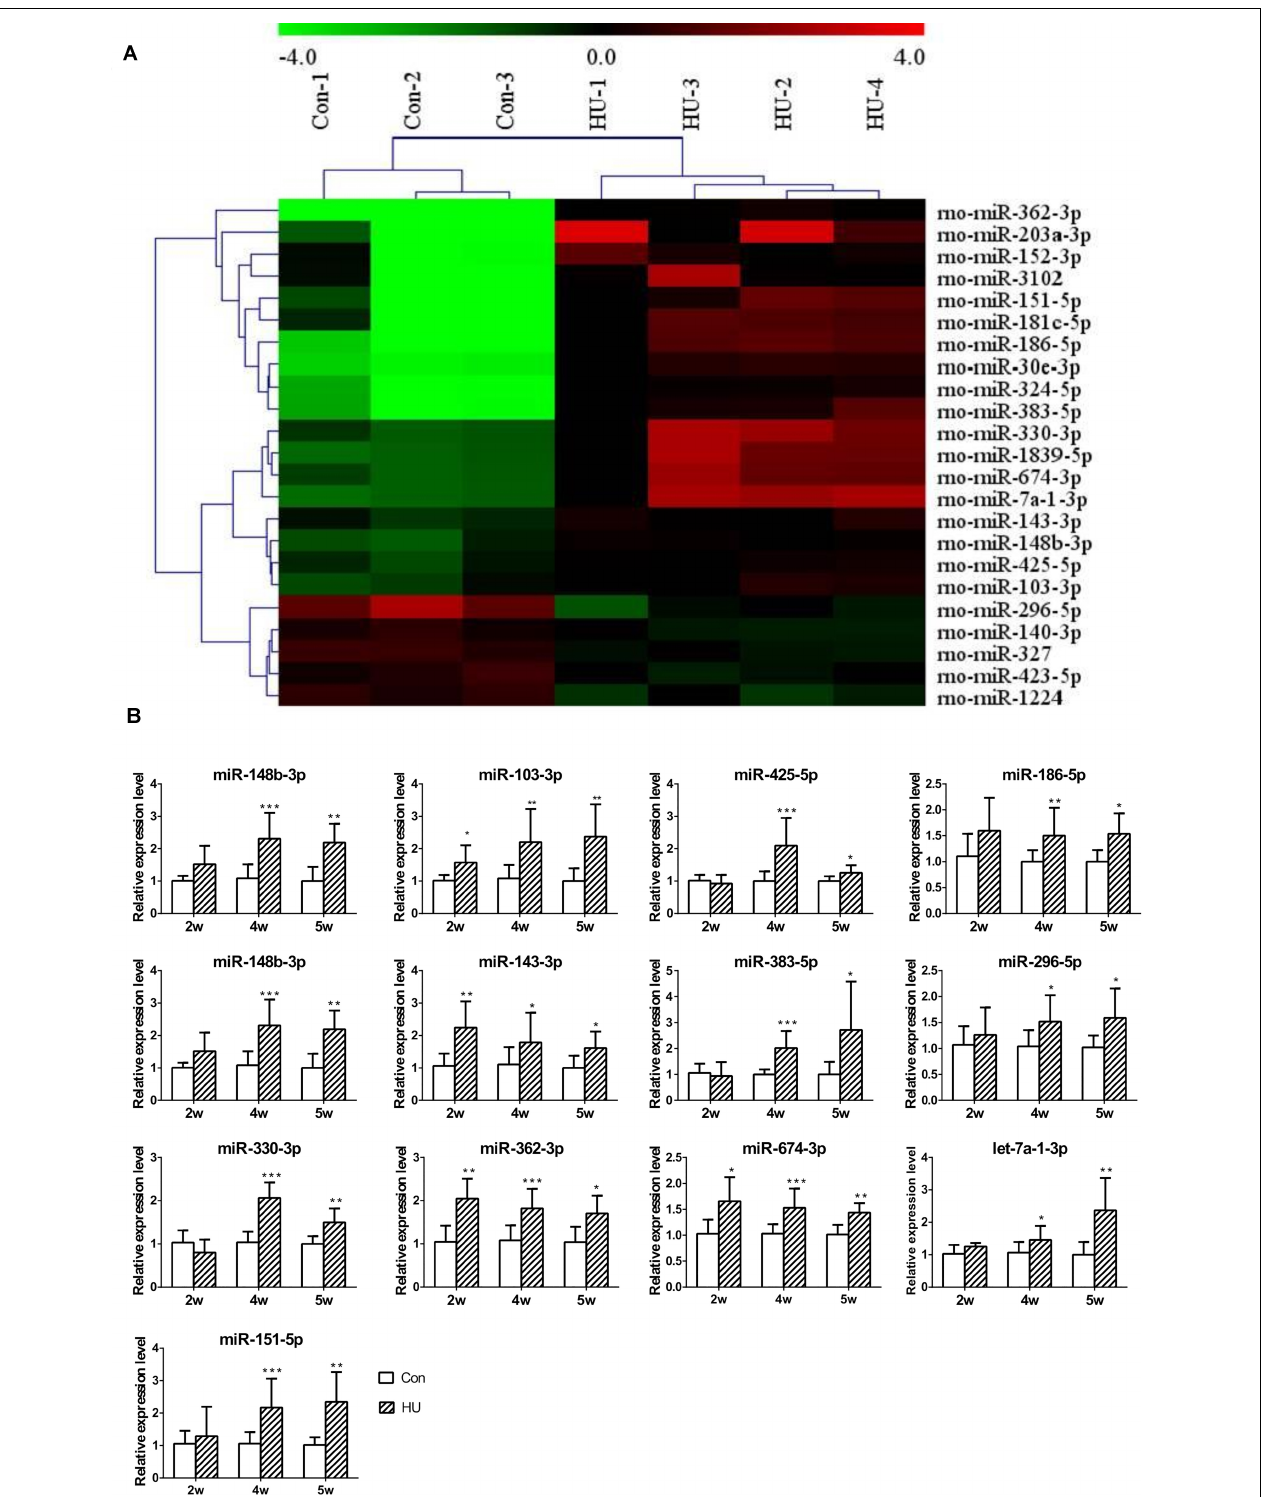
FIGURE 2 | Analysis of differential expression of serum miRNAs in HU rats. (A) miRNA microarray was performed to analyze the expression of miRNAs in the serum of HU rats; 18 upregulated and 5 downregulated miRNAs were found in the serum of HU rats compared with control groups; the cutoff was a fold change ≥ 1.5 and p value < 0.05. (B) 13 upregulated miRNAs were confirmed by qPCR which were normalized to miR-25-3p ( n = 12). * p < 0.05, ** p < 0.01, *** p < 0.001, HU vs. Con.